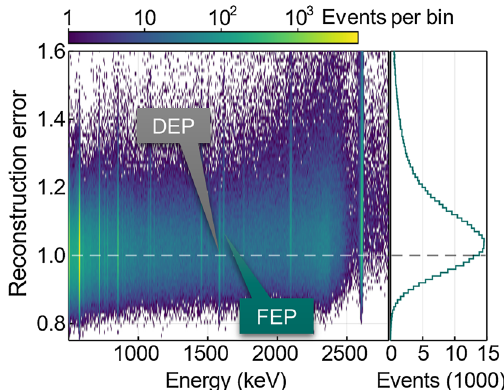
Fig. 7 Distribution of the normalized reconstruction error, ε , of the autoencoder as a function of energy (left) and its marginalized distribu- tion for events with an energy between 1000 and 3000 keV (right)